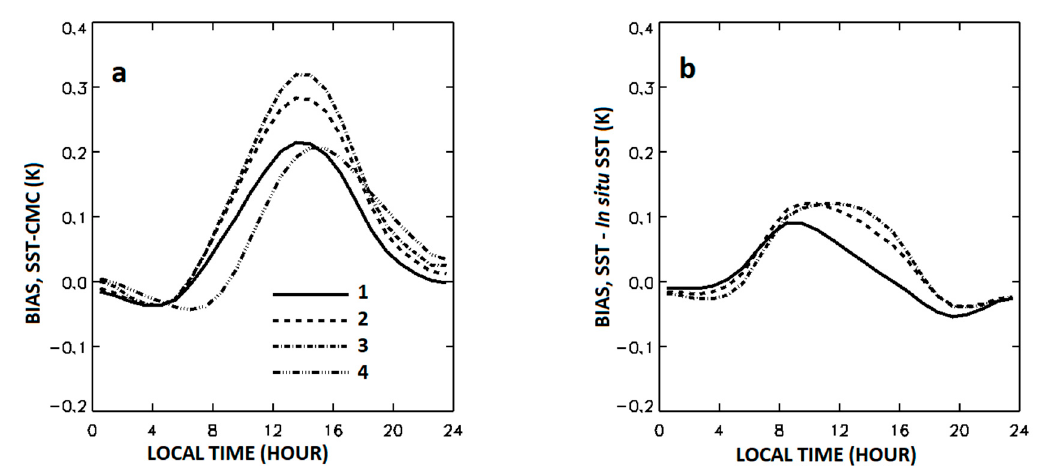
Figure 5. ( a ) Diurnal cycles in T S − T S 0 averaged over the full ABI MDS-IS (April 2017–March 2018) for (1) GR-IS SST (2) GR-L4 SST, (3) PWR-L4 SST and (4) in situ SST. ( b ) Diurnal mean deviations of (1) GR-IS SST (2) GR-L4 SST and (3) PWR-L4 SST from in situ SST. All shown as functions of local solar Table 2. Mean sensitivities, standard deviations of retrieved SST – in situ SST, and average magnitudes of diurnal cycle (DCMs), estimated from MDS-IS, using matchups with STPW < 100 kg/m 2 . Algorithm Mean Sensitivity Standard